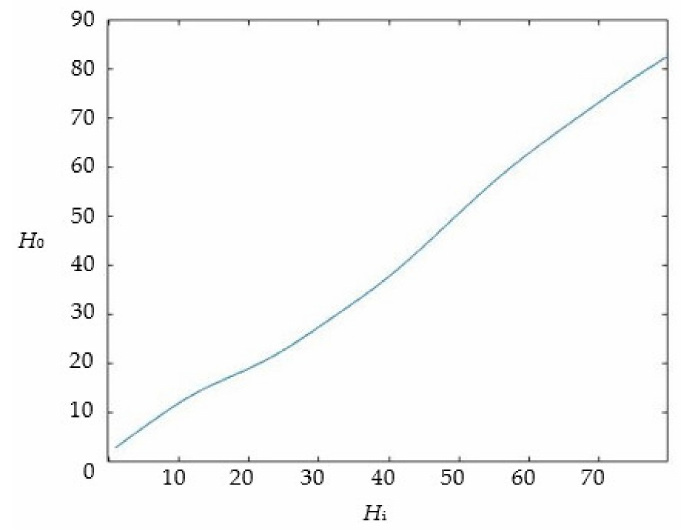
Figure 13. The relationship between H 0 and H i .